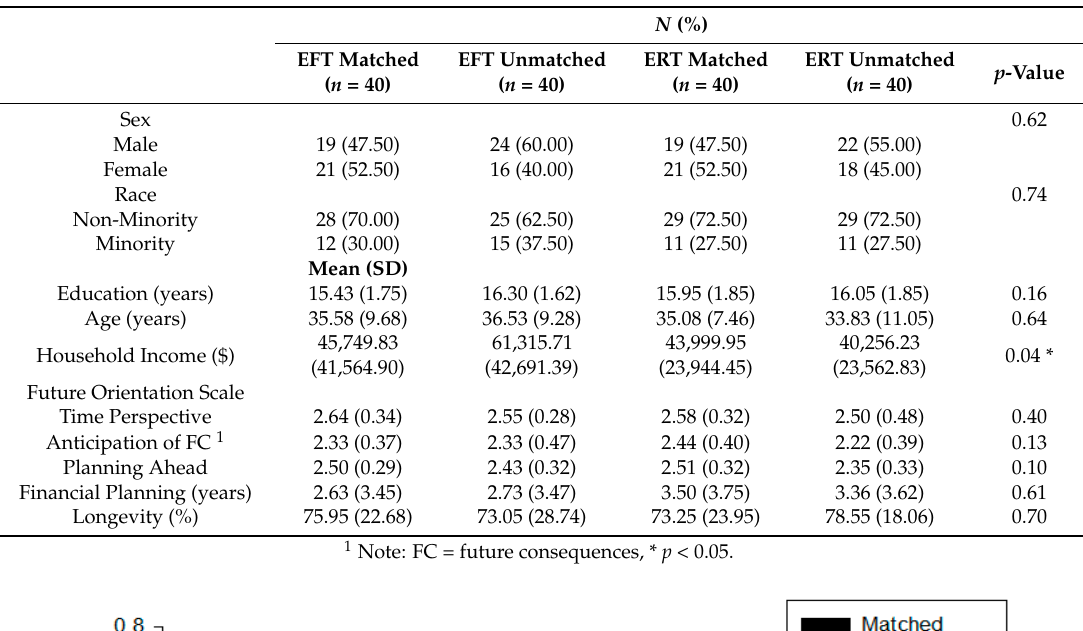
Table 2. Participant characteristics.